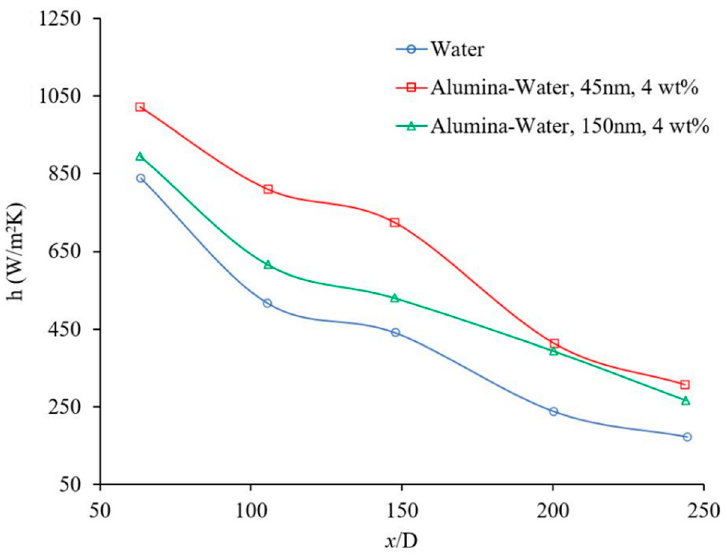
Figure 7. Effect of nanoparticle size on heat transfer coefficient, Anoop et al.